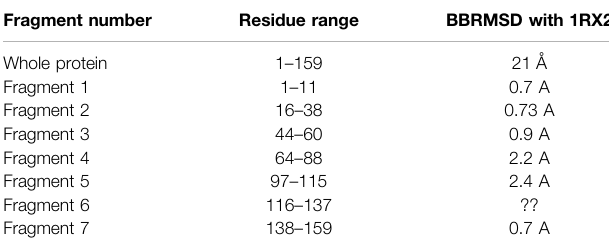
TABLE 2 | The BBRMSD of the different fragments generated through the complete run of REDCRAFT from residue 1 until residue159 of DHFR.